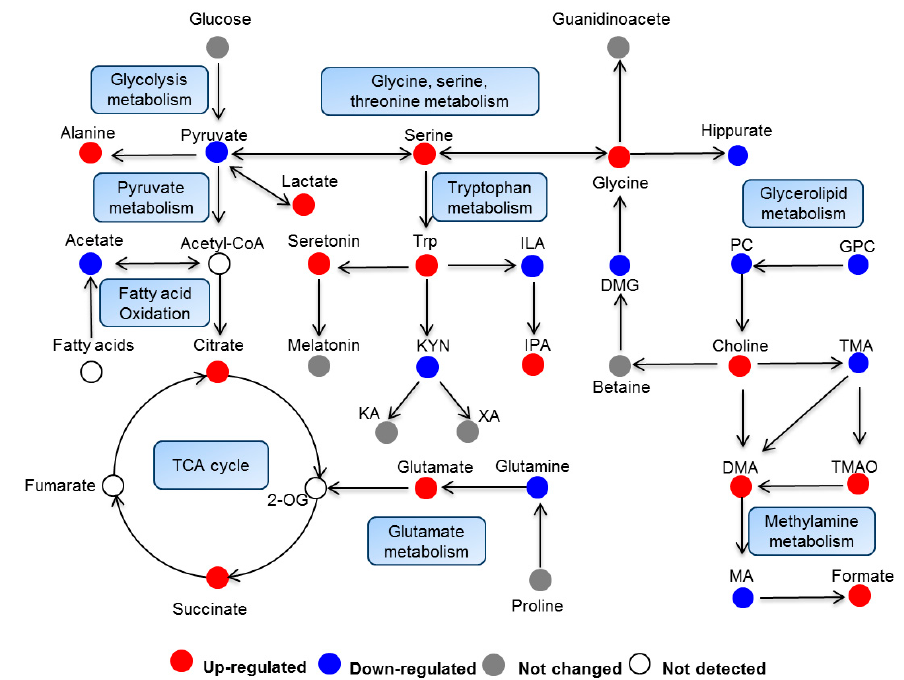
Figure 5. Perturbed pathways and changed metabolites induced by rac -metalaxyl and metalaxyl-M.